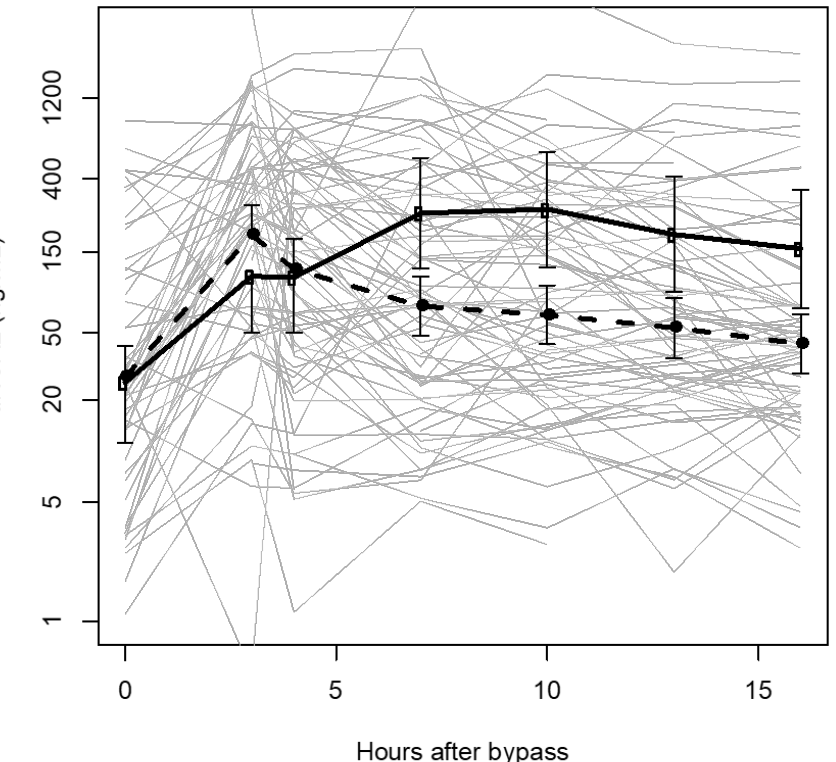
Figure 2. Mean uNGAL levels over time in neonates with and without AKI. Mean uNGAL concentrations (ng/mL) at collection times after cessation of cardiopulmonary bypass in patients with AKI (open circles, solid line) and without AKI (closed circles, dashed line). Mean log(uNGAL) values and error bars representing ± 95% CIs were derived from a hierarchical mixed-effects regression model of the interaction of AKI status and time. Values shown on the y axis scale have been exponentiated. Individual trajectories of log(uNGAL) are shown using thin gray lines. To test whether AKI was related to uNGAL at each collection interval, we computed odds ratios using logistic regression models controlling for sex, gestational age (GA), CPB time, RACHS-1 score,